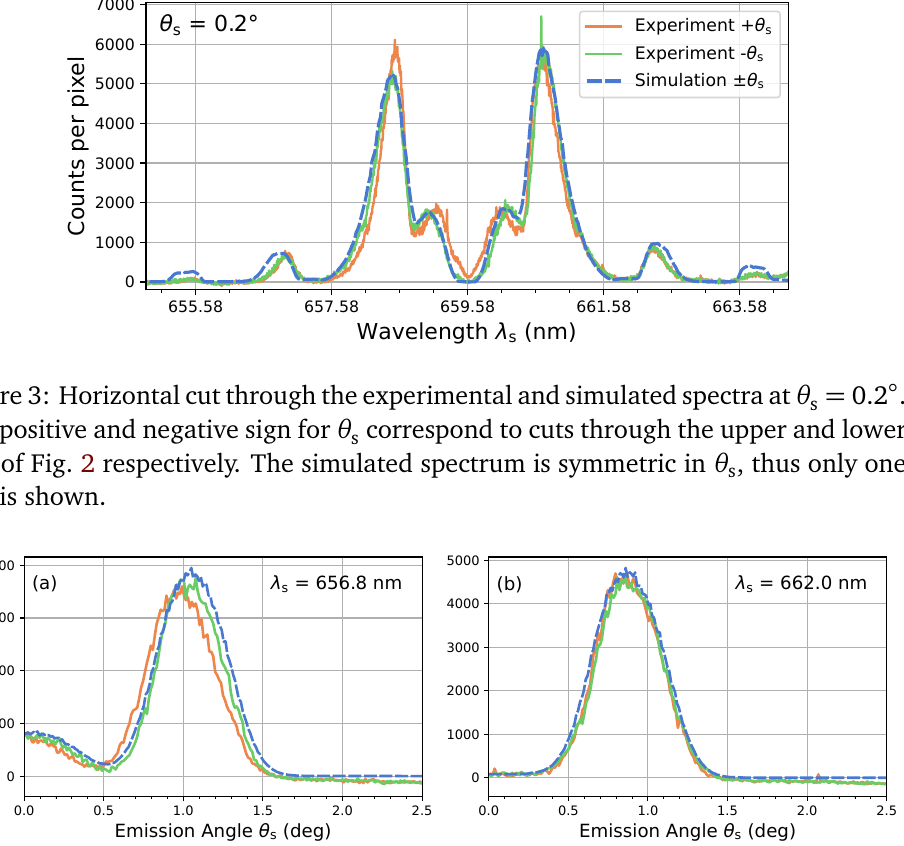
Figure 4: Vertical cuts through the experimental and simulated spectra. Panel (a) shows a cut in the up-conversion regime, panel (b) in the down-conversion regime. The color coding is the same as in Fig.